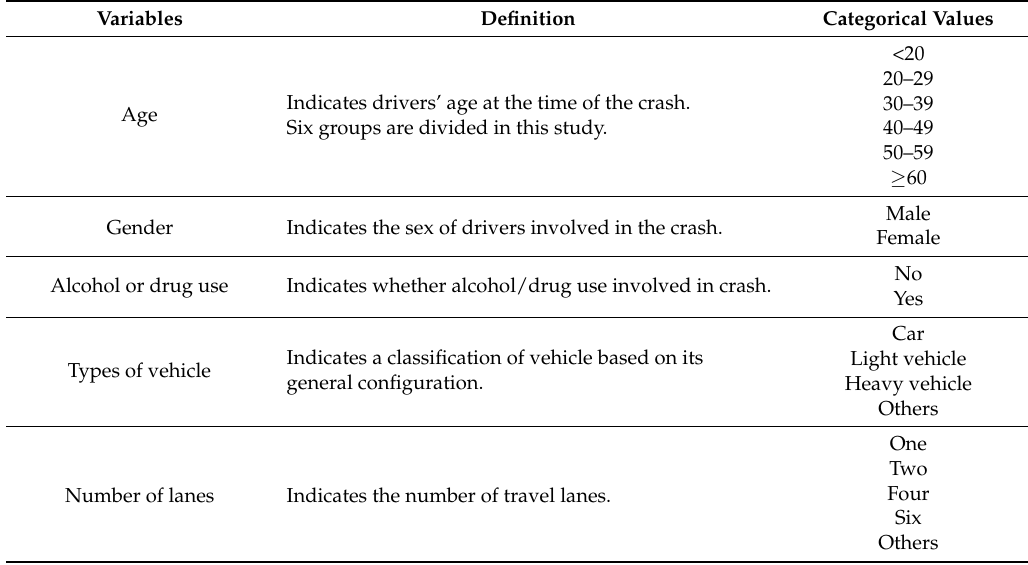
Table 1. Independent variables used in this